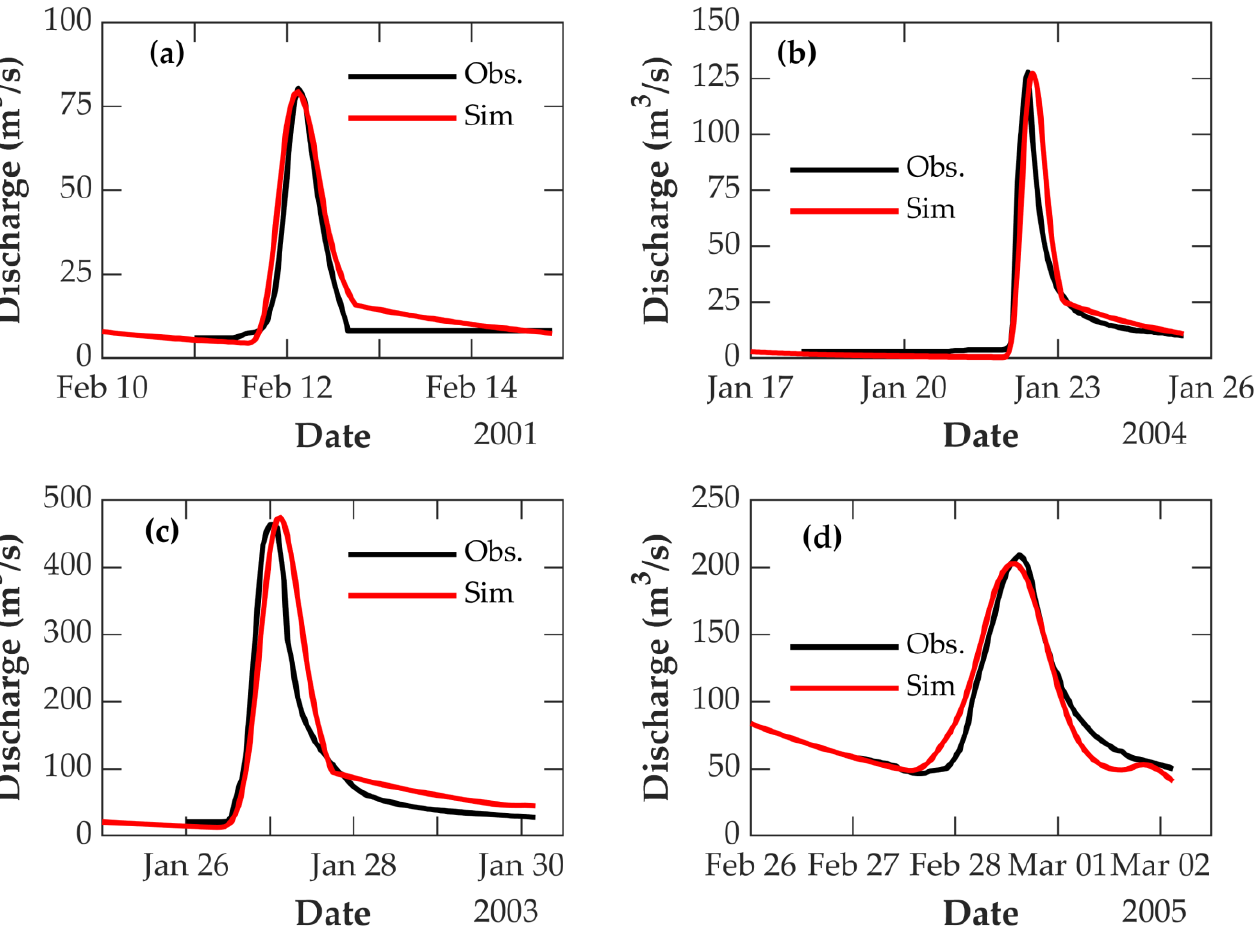
Figure 7. Simulated versus observed hydrographs for two calibration events ( a , b ) and two verification events ( c , d ); HEC-HMS is used.